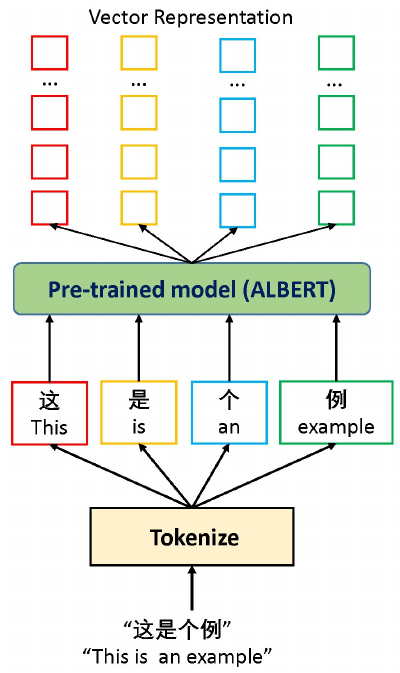
Figure 2. An example of input information being processed by the initial encoding layer in the proposed model. It shows the schematic flow of initializing the